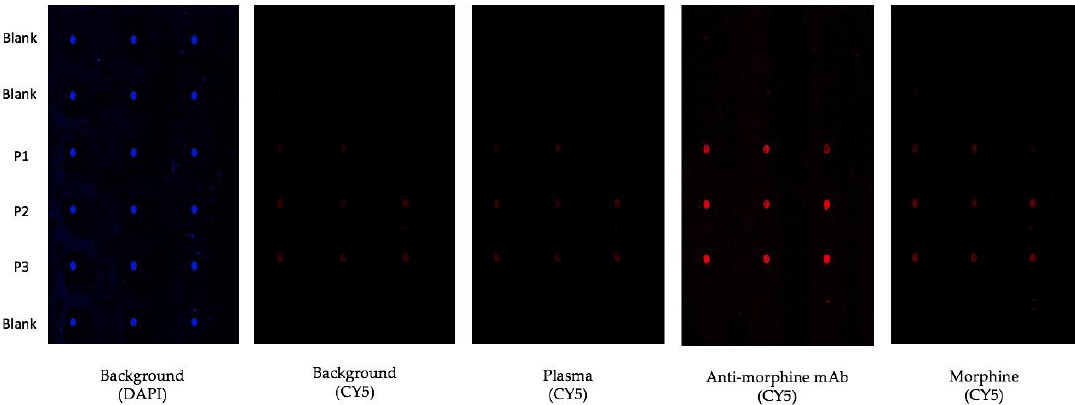
Figure 8. Immobilize illuminating peptides onto a microarray chip using efficient Cu-free click chemistry.